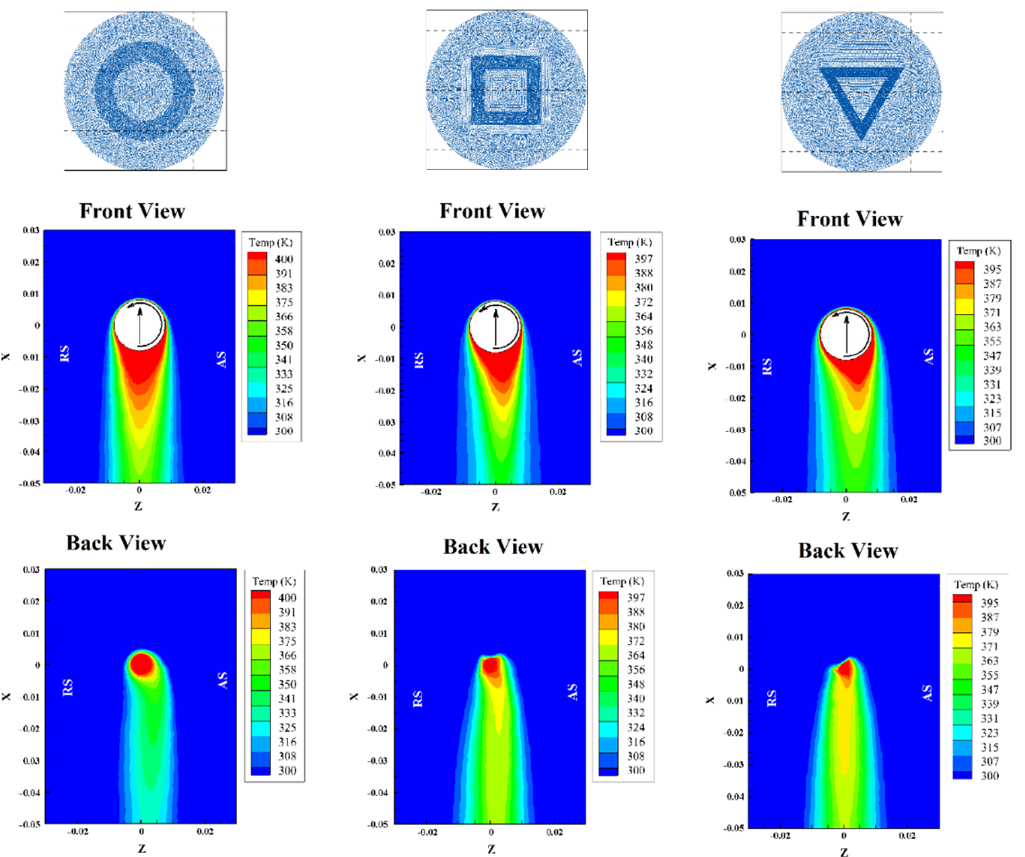
Figure 22. LFSW pin profile meshed and simulation results of heat flux on top and back side of PMMA sheet [72].